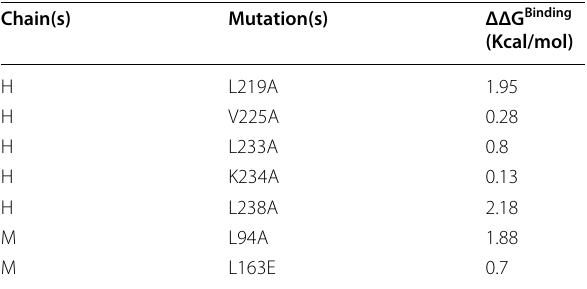
Table 5 MutaBind2 mutation-induced change in binding affinity